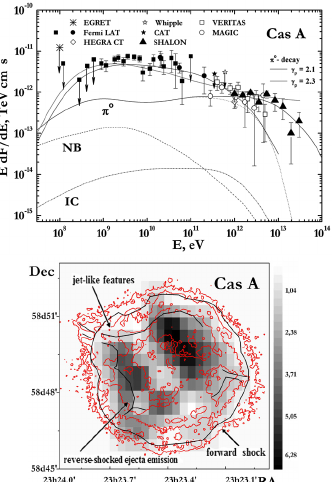
Figure 1. Characteristics of Cas A: top: Spectral energy dis- tributions of high- and very high energy γ -ray emission by SHALON ( (cid:31) ) in comparison with other experiments. NB - non- thermal Bremsstrahlung gamma-ray energy flux; IC - Inverse Compton γ -ray energy flux [4]. The red and blue lines are calcu- lations from [3]. bottom: Image of SNR at energies > 0 . 8 TeV by SHALON (grey scale). Red contours are the X-ray emission by Chandra and show 7%, 19% and 54% of the image maximum.